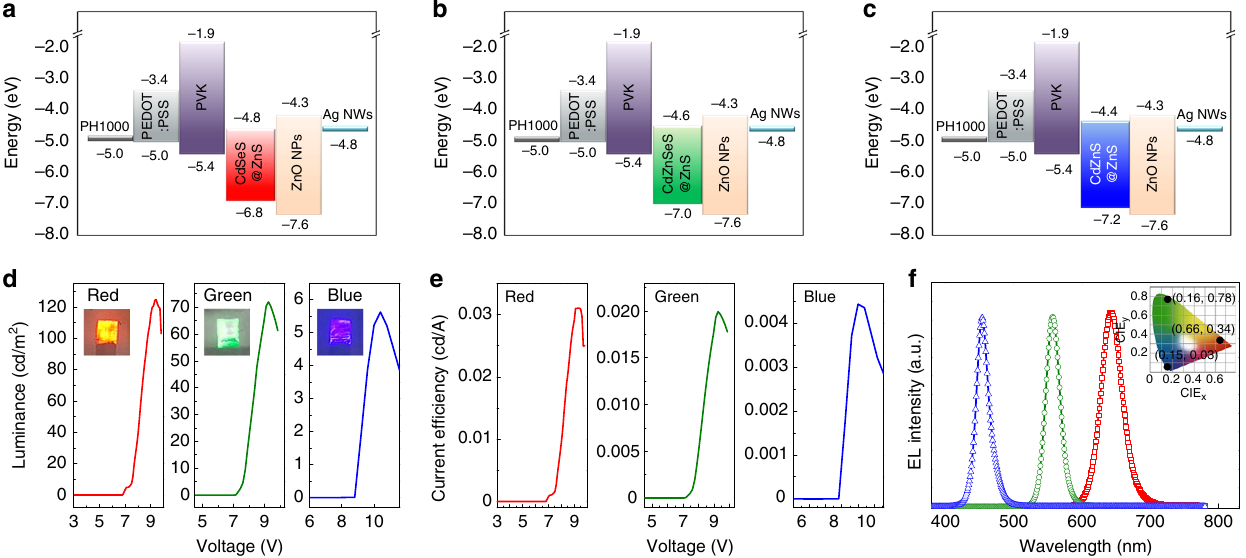
Fig. 5 Luminance – current – voltage (LIV) characteristics of the QD light-emitting diodes (QD-LEDs) fabricated using the pen-drawing method. Energy levels of red (R), green (G), and blue (B) QD-LEDs. Highest occupied molecular orbital (HOMO) and lowest unoccupied molecular orbital (LUMO) levels of PH1000, PEDOT:PSS, PVK, QDs, ZnO NPs, and Ag NWs. CdSeS@ZnS for R emission ( a ); CdZnSeS@ZnS for G emission ( b ); and CdZnS@ZnS for B emission ( c ). Luminance ( d ), ef fi ciency ( e ), and electroluminescence spectra and the Commission Internationale de l'Elcairage (CIE) color coordinates ( f ) corresponding to the R, G, and B emitting QD-LEDs with the structure of PH1000/PEDOT:PSS/PVK/QDs (CdSeS@ZnS for R, CdZnSeS@ZnS for G,